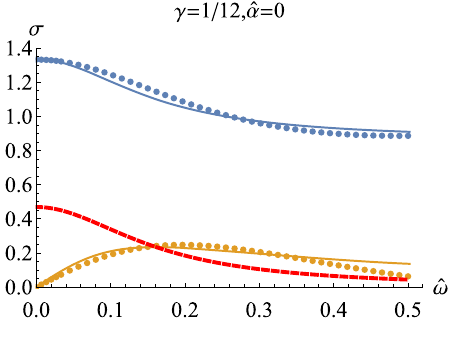
Fig. 2 The low frequency behavior of the optical conductivity without momentum dissipation for γ = 1 / 12 (left plot) and γ = 10 (right plot). The left plot is fitted by a modified Drude formula (22). The red dashed lineinleftplotistherealpartofopticalconductivitywhenfittedwiththe